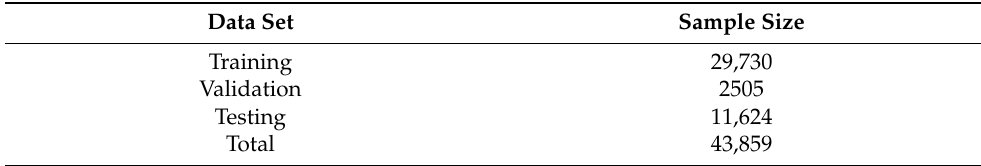
Table 1. Sample data used in the study. The data were balanced using the method of Lee et al. [32]. Data Set Sample